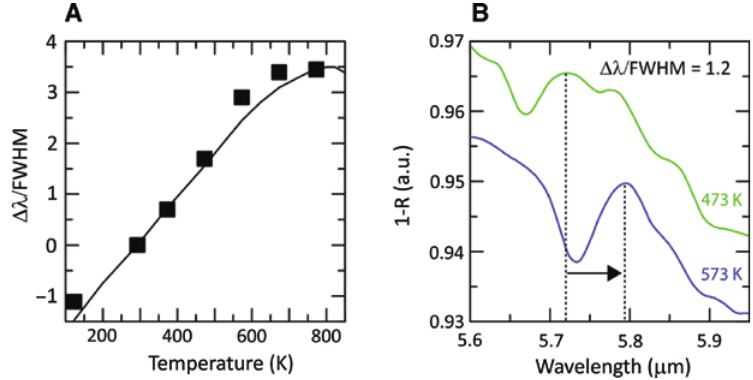
Figure 3: Normalized tunability ( Δλ /FWHM) of high-order MO mode in the Ge resonator. (A) Temperature-dependent MO shifts normalized to the resonance linewidth. (B) Tuning by more than one resonance linewidth ( Δλ /FWHM = 1.2) with a Δ T = 100 K temperature